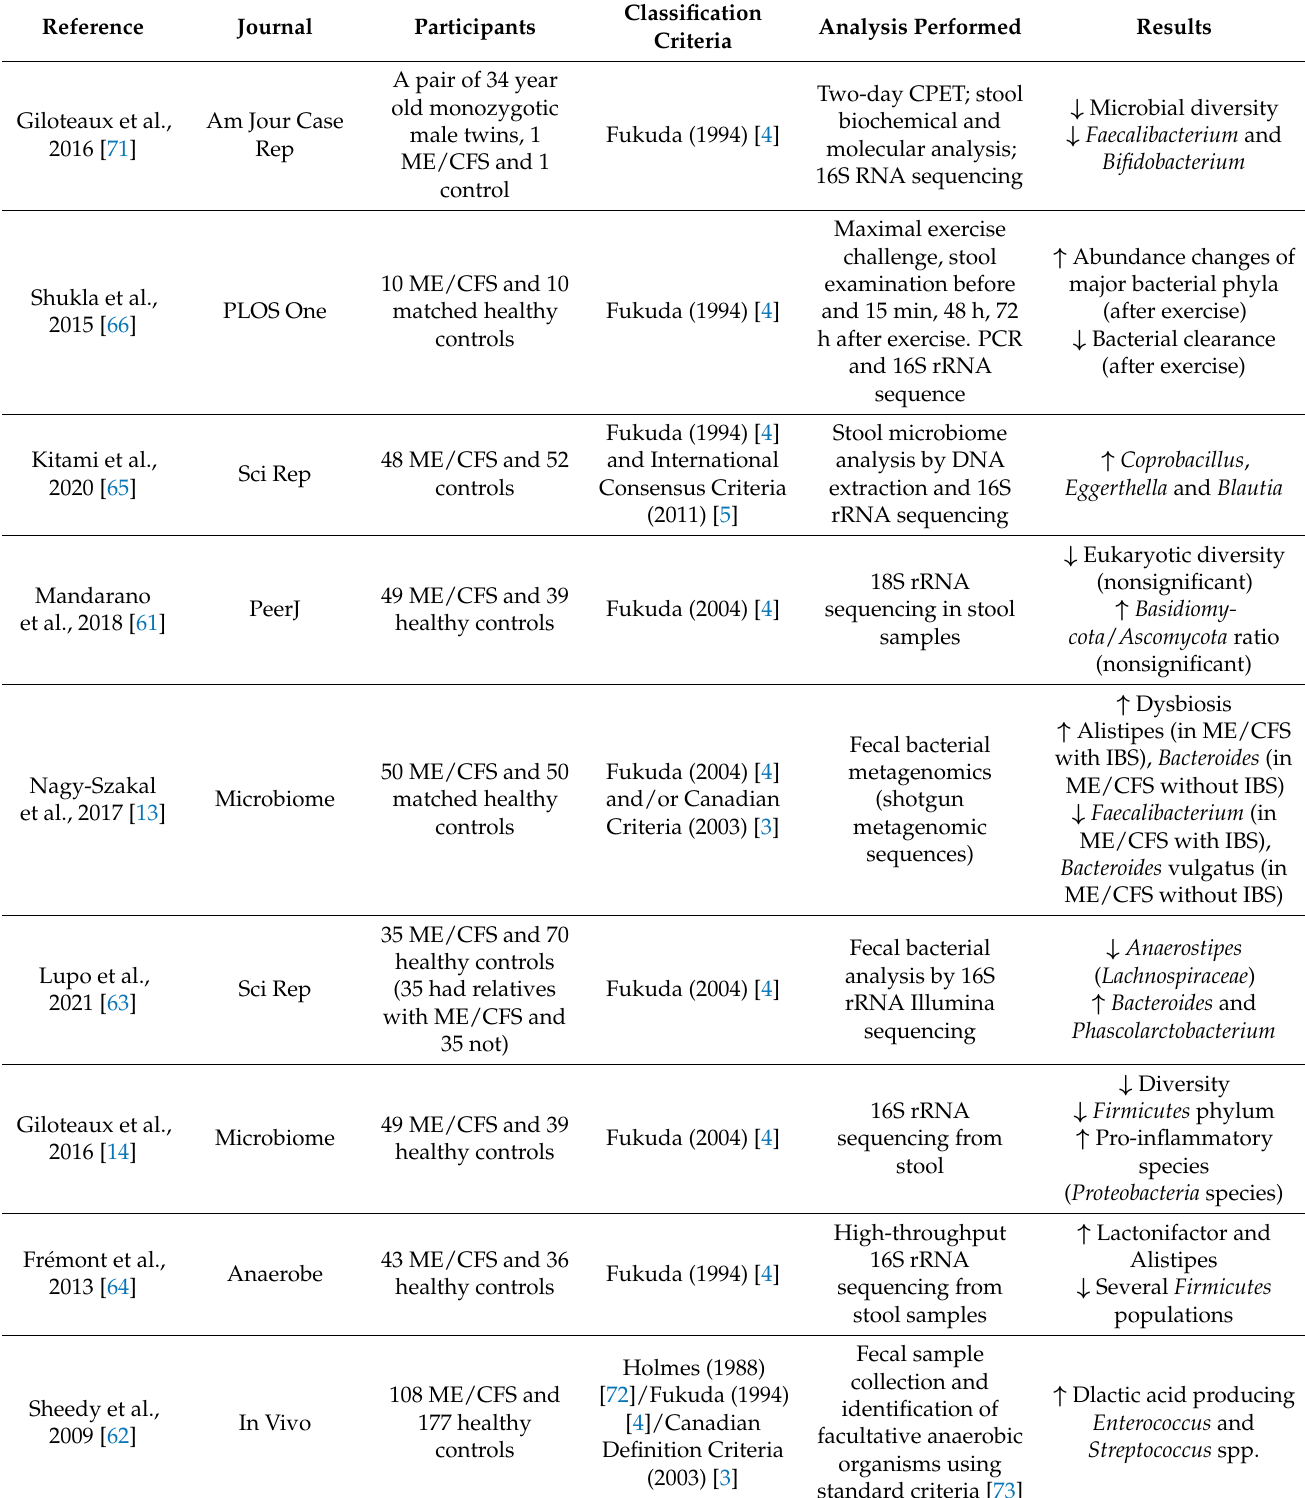
Table 1. Summary of studies concerning dysbiosis in